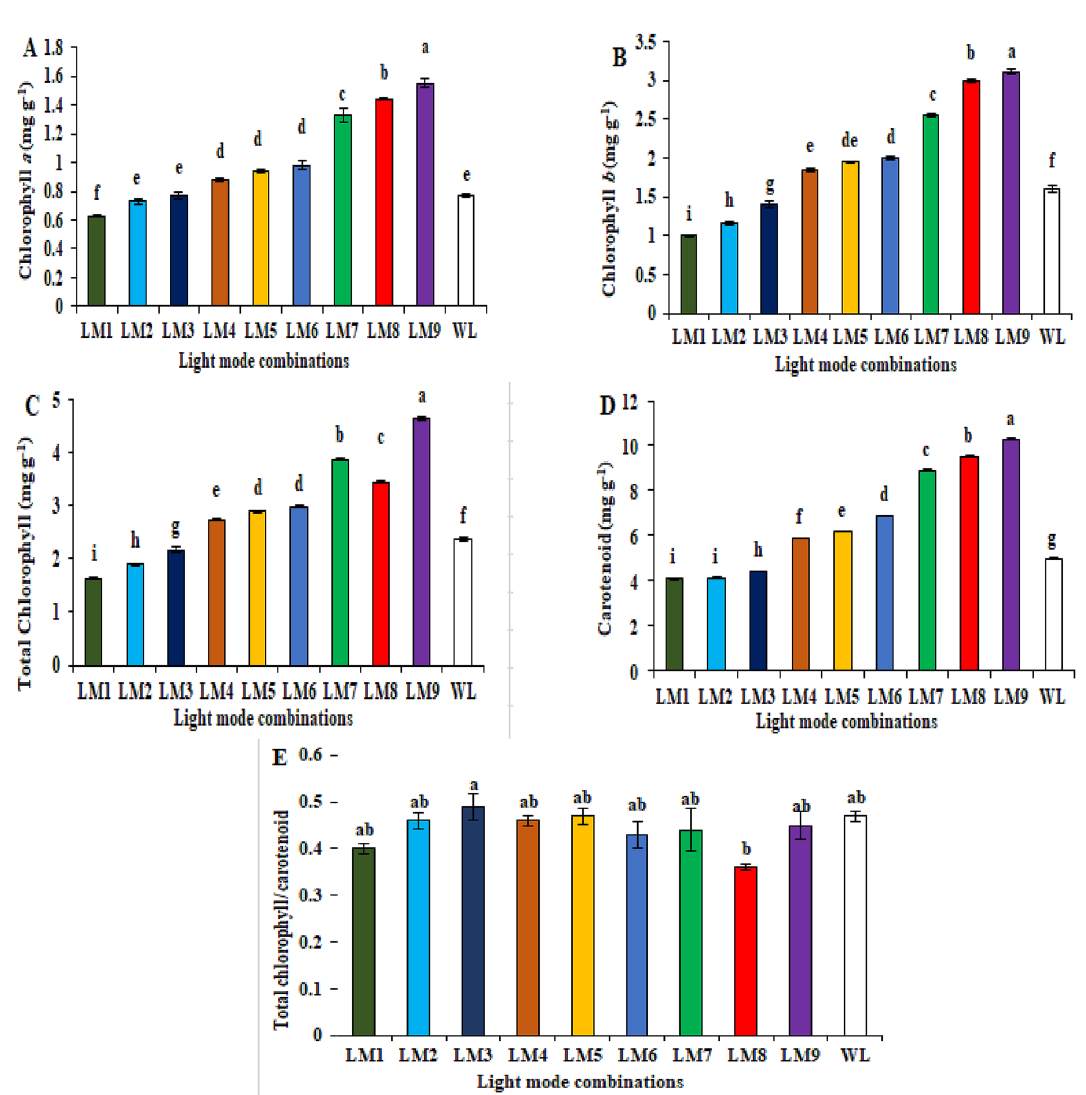
Figure 2. Effect of modes LED light on photosynthetic pigments content [chlorophyll a ( A ), chlorophyll b ( B ), total chlorophyll ( C ), carotenoid ( D ), and total chlorophyll/carotenoid contents ( E )] in cucumber seedlings. Means followed by the same letter within the same series are not significantly different according to Duncan’s multiple range test ( P ≤ 0.05). See Table 4 for LM